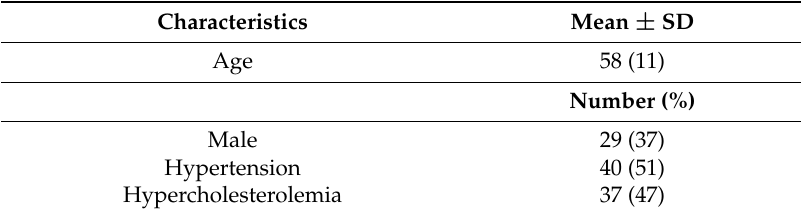
Table 1. Baseline characteristics and univariate associations with hs-troponin (Singulex assay) in